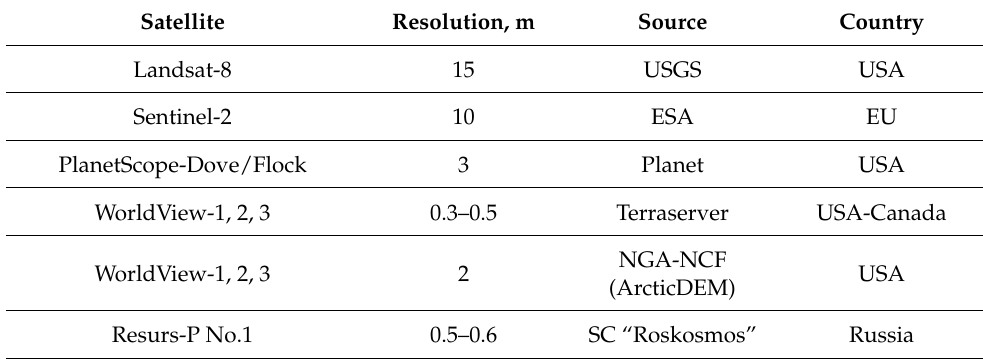
Table 1. Brief characteristics of the used remote sensing (RS) data from space. Satellite Resolution, m Source Country Landsat-8 15 USGS USA Sentinel-2 10 ESA EU PlanetScope-Dove/Flock 3 Planet USA WorldView-1, 2, 3 0.3–0.5 Terraserver USA-Canada NGA-NCF WorldView-1, 2, 3 2 USA (ArcticDEM) Resurs-P No.1 0.5–0.6 SC